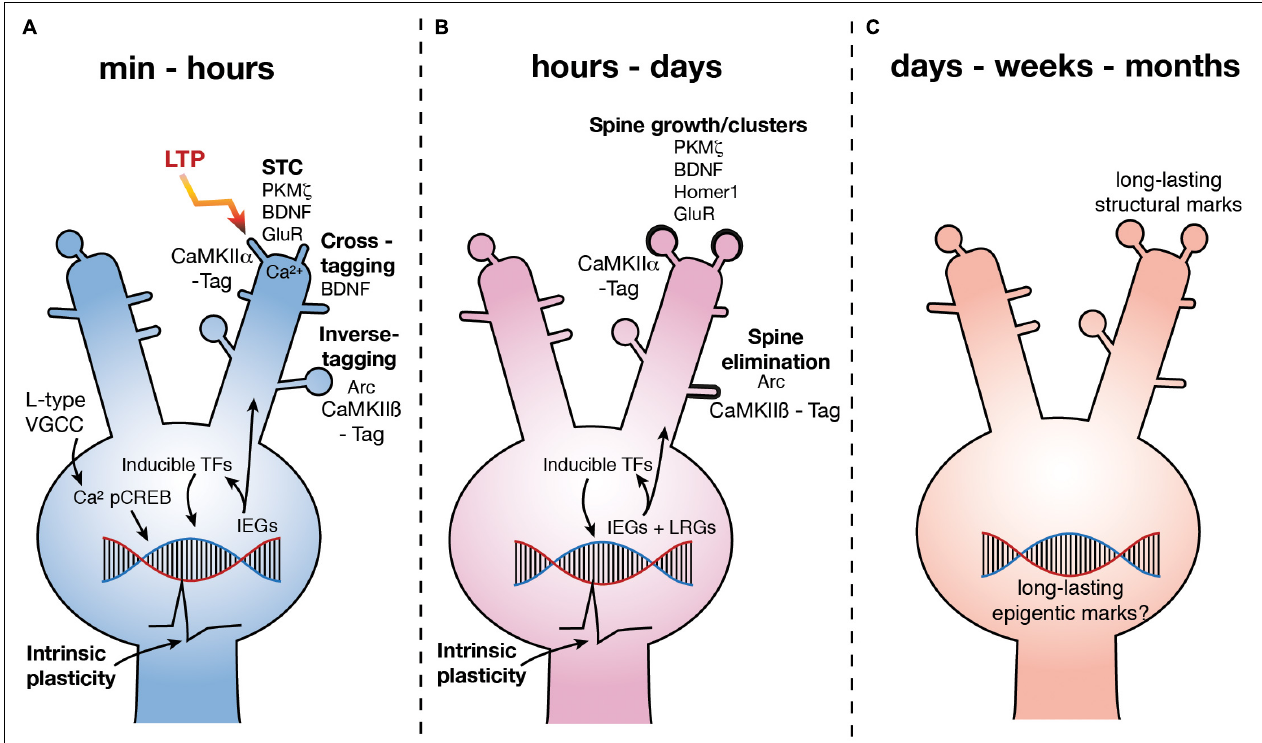
FIGURE 1 | Molecular mechanisms underlying LTP3. (A) Upon LTP induction, Ca 2 + influx via L type VGCCs leads to the phosphorylation of CREB. pCREB stimulates the expression of a number of IEG’s leading to the production of PRPs, some of which are involved in synaptic plasticity via STC (potentiation at CaMKII α tagged synapses), inverse tagging (depotentiation or depression at CaMKII β tagged synapses) and cross-tagging (synaptic depression) mechanisms. Other IEG’s are inducible TFs which stimulate subsequent waves of gene expression. Further, activation of CREB is also known to increase excitability (depicted as action potential waveform). (B) Over hours to days, subsequent waves of gene expression are involved in spine growth as well as spine elimination. Excitability remains high for at least 5 h (depicted as action potential waveform). (C) LTP persists for months, yet how changes in gene expression are regulated and how this regulates